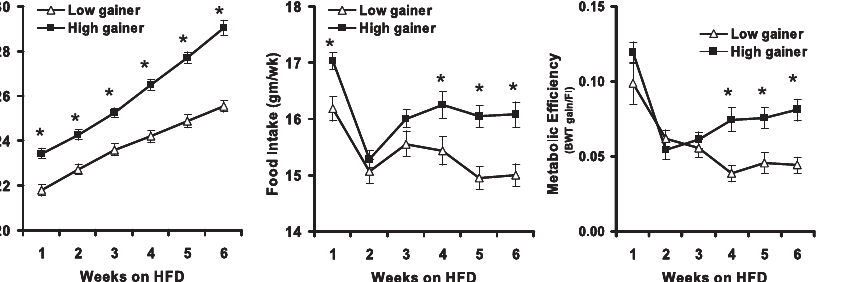
Figure 3. Chronology of Body Weight, Food Intake, and Metabolic Efficiency of Mice with Food Intake Restricted to an Amount Equivalent to That Consumed by 80% of Experimental Mice Twenty mice were in each group. Differences in phenotype between groups are marked by an asterisk (*) at a significance level of p , 0.01 DOI: